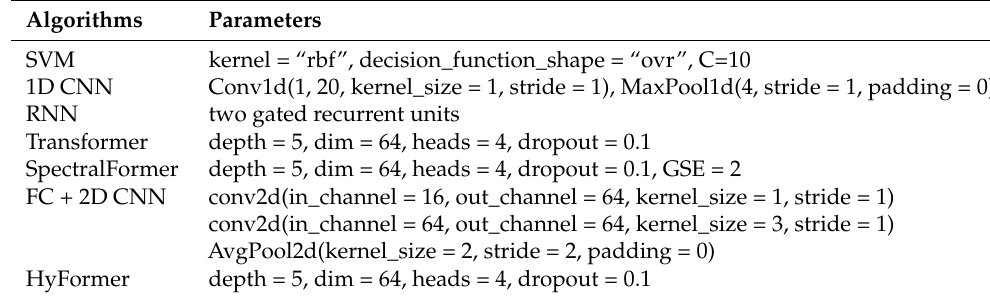
Table 2. Multi-method parameters.